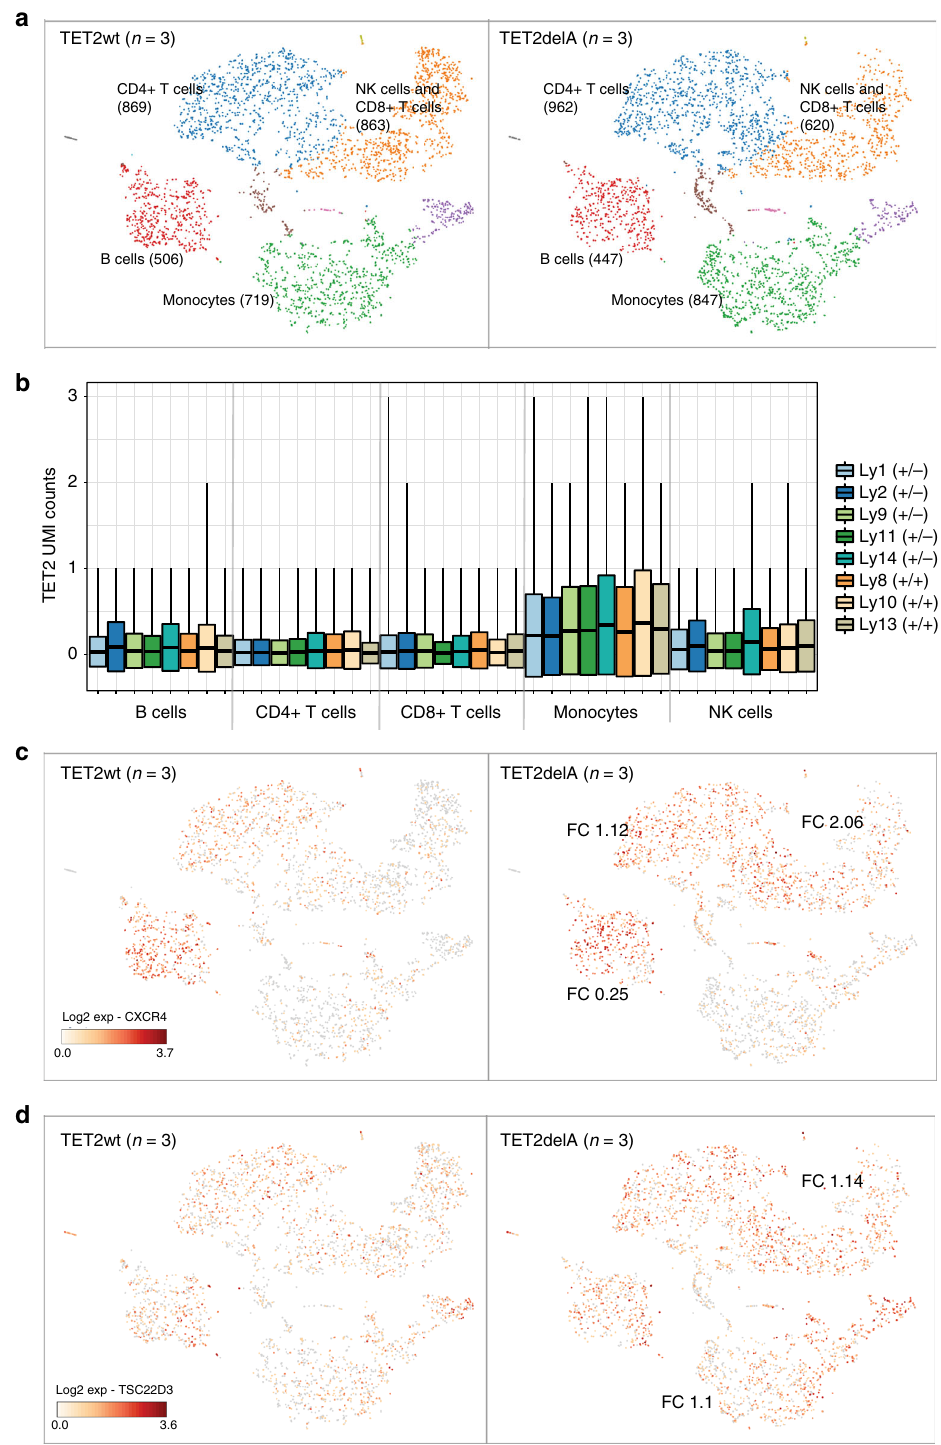
Fig. 5 Single-cell RNA-sequencing analysis from peripheral blood. a The main cell types were present in similar numbers between cancer-free TET2delA carriers (Ly9, Ly11, and Ly14; right) and wild-type individuals (Ly8, Ly10, and Ly13; left). Colors represent blood cells with similar expression pro fi les in K -means ( K = 10) clustering. Each point represents a cell in the coordinates speci fi ed by the two t-SNE (t-distributed stochastic neighbor embedding) components. b TET2 expression in each of identi fi ed cell types represented with unique molecular identi fi er (UMI) counts. Boxplot shows the mean ± standard deviation. TET2delA carriers are marked with + / − and wild-type individuals with + / + . c CXCR4 was the most signi fi cantly increased transcript in natural killer (NK) cells and CD8 + T cells [log2 fold change (FC) 2.06], CD4 + T cells (FC 1.12), and all cell types compiled (FC 0.92), in cancer-free mutation carriers (right) as compared to non-carriers (left). d TSC22D3 expression was signi fi cantly increased in NK cells and CD8 + T cells (FC 1.14) and monocytes (FC 1.1) of mutation